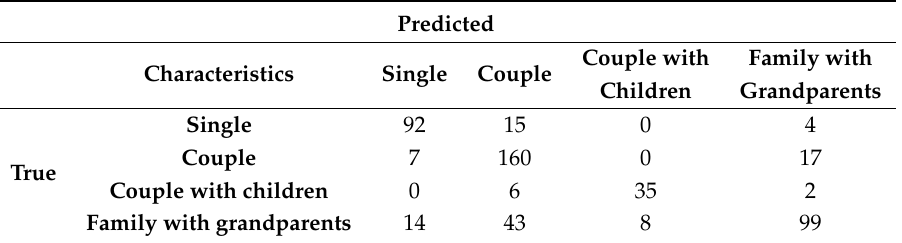
Table 5. The confusion matrix of number of inhabitant(s).